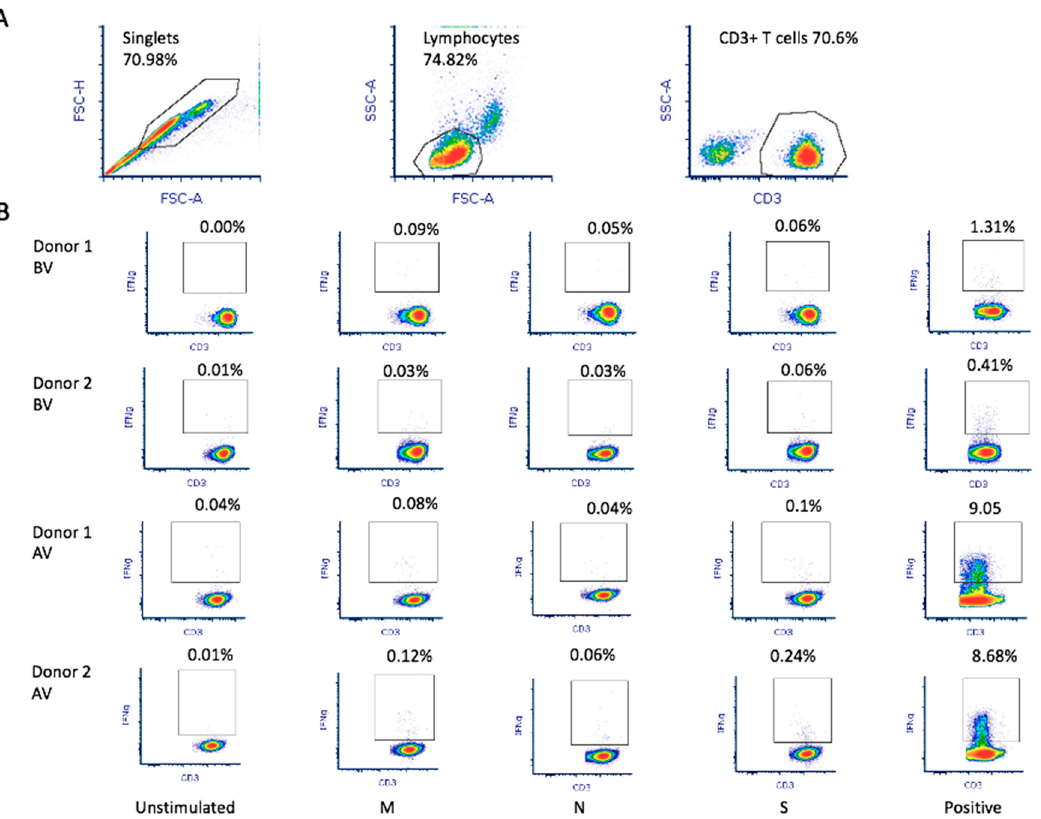
Figure 1. SARS-CoV-2 antigen-specific T-cell production and reactivity werefirst tested using 10 mL of whole peripheral blood collected from each donor in EDTA tubes. ( A ) Flowcytometry analysis was based on doublet exclusion before selection of the population of interest (lymphocytes) and CD3+ T-cells. A minimum of 100,000 events within the population of interest were analyzed. ( B ) The percentage of CD3+ IFN- γ + cells was quantified upon stimulation with the different SARS-CoV-2 peptides (M, N, and S). For each experiment, an unstimulated sample was used as negative control and a non-specific stimulation was used as positive control. Triplicate experiments were performed for both donors before vaccination (BV) and after vaccination (AV).